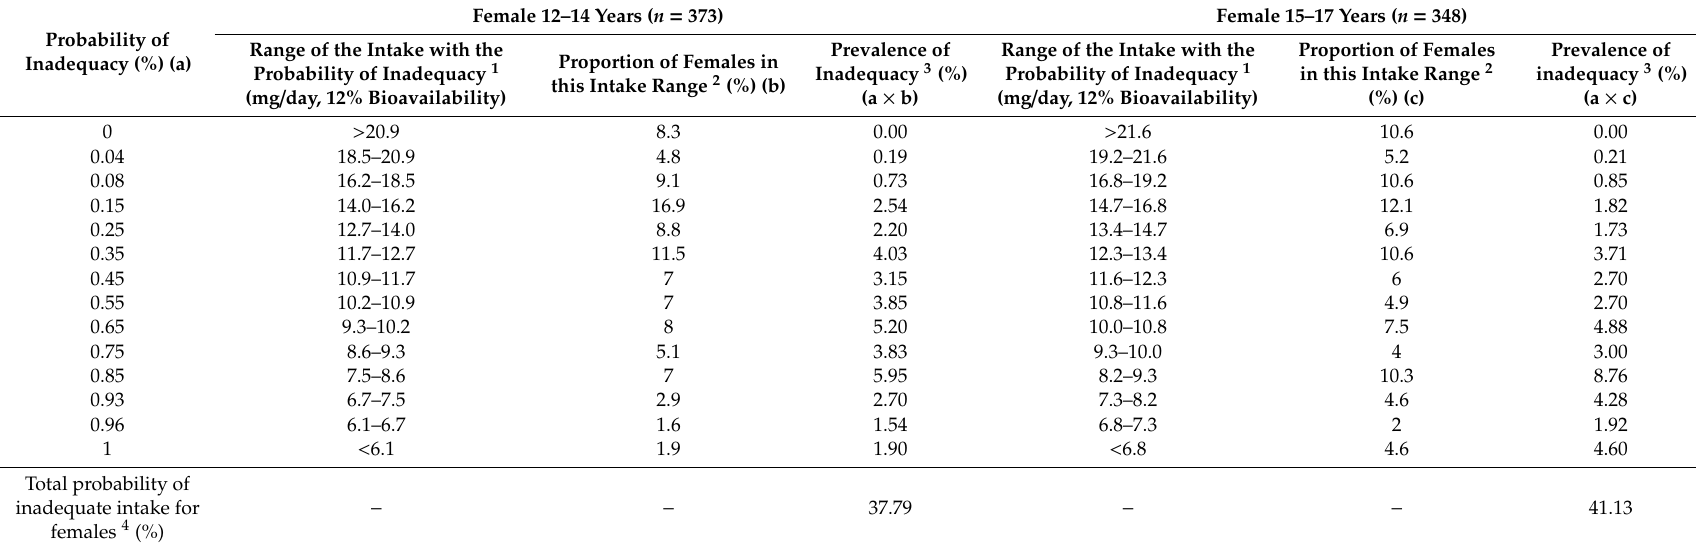
Table 6. The probability of inadequate iron intake for Korean females aged 12–17 years old, calculated using the full probability approach. Probability of Inadequacy (%)